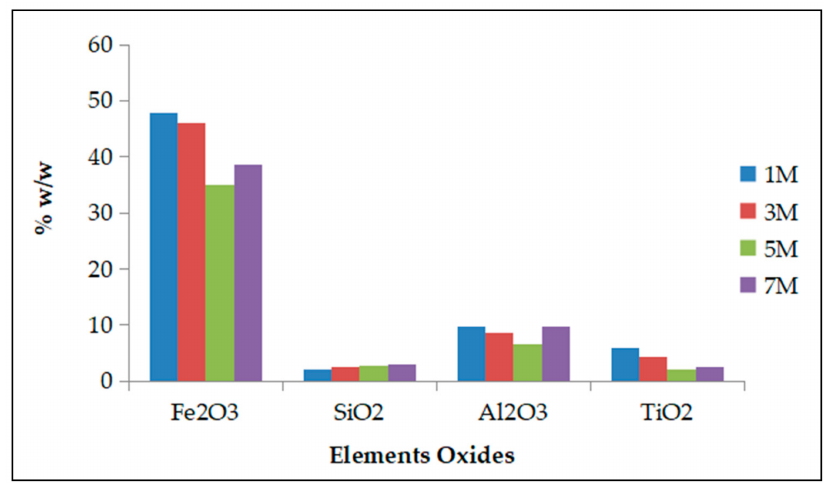
Figure 5. X-ray fluorescence spectroscopy (XRF) analysis of main elements oxides in the precipitates after leaching process with different acid molarities (effect of molarity).